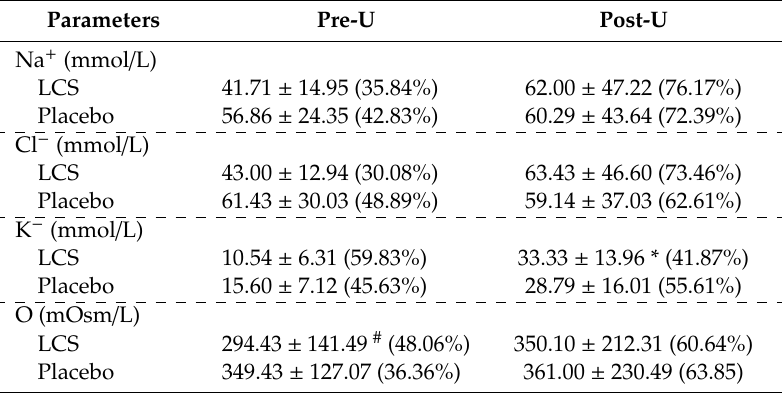
Table 2. Changes in electrolytes and osmolality of urine after exhaustive endurance